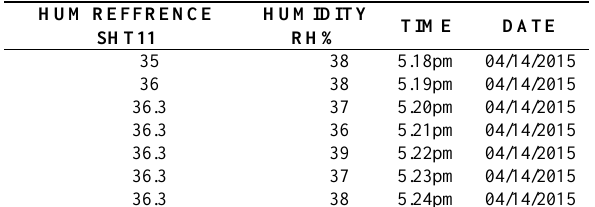
Table 2. An example of humidity values logged in Excel files (HUM1, HUM2).